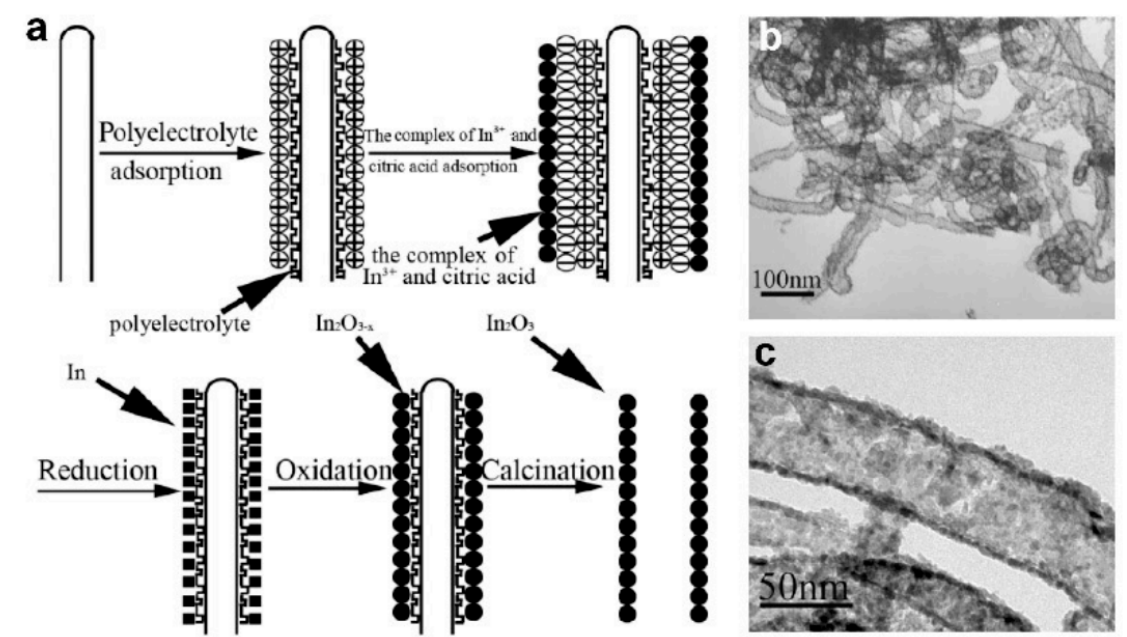
Figure 11. ( a ) Schematic diagram for the growth process of In 2 O 3 hollow nanofibers. ( b , c ) TEM images of regular In 2 O 3 nanotubes prepared by the calcination of In 2 O 3 /polyelectrolyte/CNT nanocomposites at 550 °C in O 2 for 3 h. Reprinted with permission from [156]. Copyright 2007 Wiley.